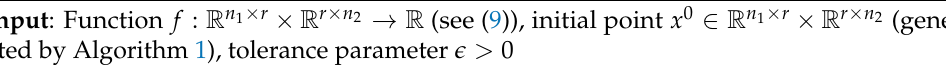
Algorithm 8 QR Riemannian gradient descent (QRRGD)